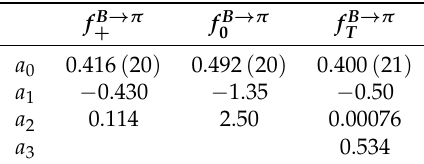
Table A1. Parameters of B → π form factors in Equation